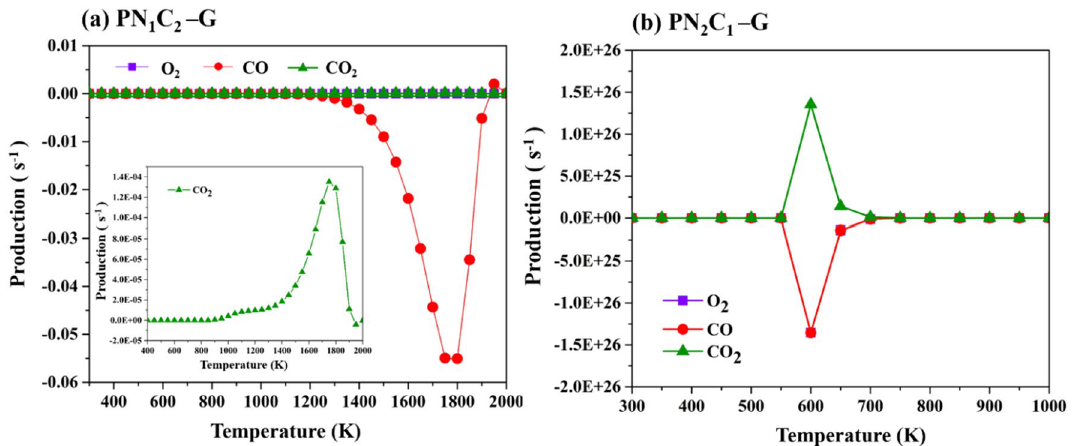
Figure 8. O 2 , CO, and CO 2 production as a function of temperature during CO oxidation via ER mechanisms on ( a ) PN 1 C 2 -G and ( b ) PN 2 C 1 -G